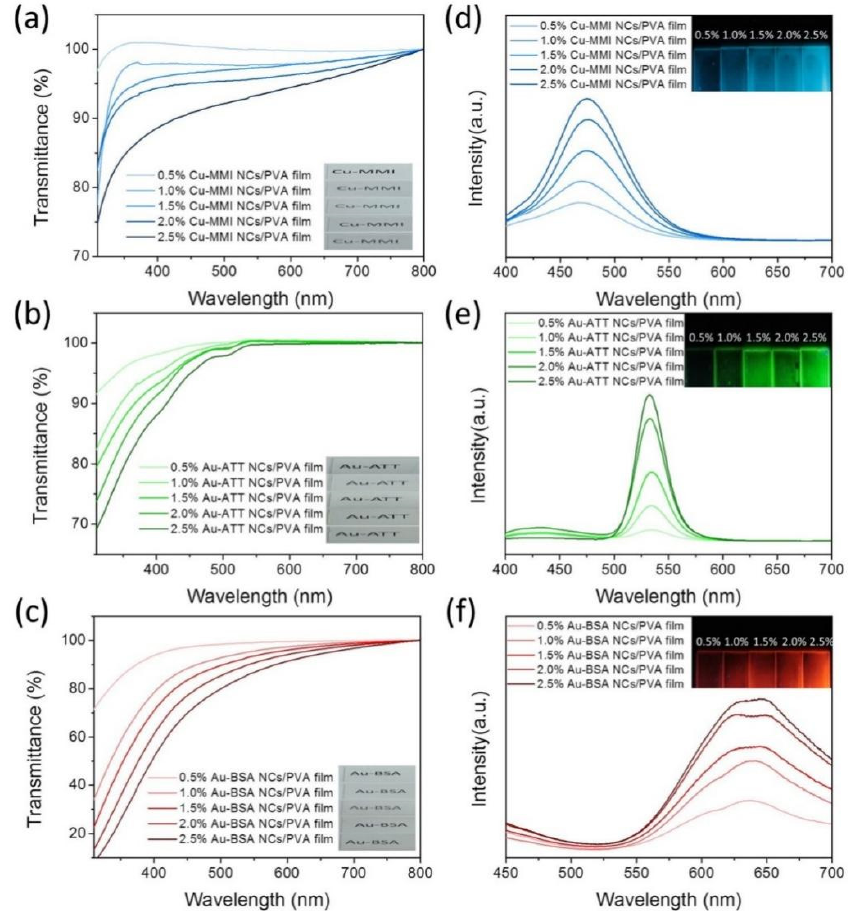
Figure 2. The transmission spectra of ( a ) Cu-MMI NCs/PVA film, ( b ) Au-ATT NCs/PVA film, and ( c ) Au-BSA NCs/PVA film with different NC concentrations. Insets of ( a – c ) exhibit the transparency of the composite films with corresponding photographs under room-light. The PL spectra of ( d ) Cu-MMI NCs/PVA film, ( e ) Au-ATT NCs/PVA film, and ( f ) Au-BSA NCs/PVA film with different NC concentrations. Insets are the corresponding photographs under excitation of 365